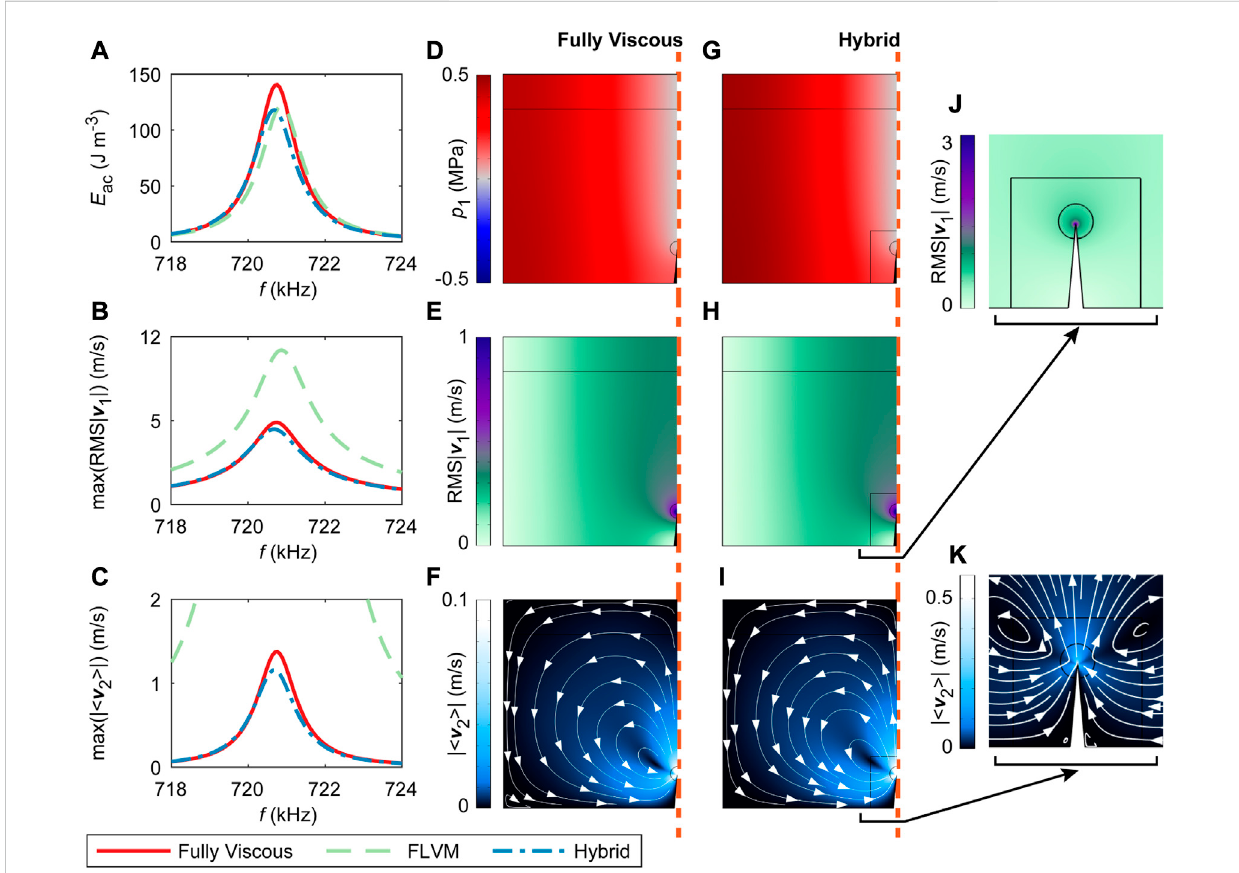
FIGURE 5 Different modeling approaches validated with a rectangular channel containing a sharp-edge structure. We compare the performance of the Fully Viscous model according to Muller et al. [15], the FLVM model from [22], and the Hybrid model outlined in Figure 2 that combines the two former approaches. The comparison is madefor the fi rst resonance modeinwater alongthechannelwidth a = 1 mm, with h =100 μ m, b =150 μ m, and α = 10 ° . (A) Average acoustic energy density E ac , (B) maximal root-mean-square acoustic velocity RMS| v 1 |, and (C) maximal Eulerian streaming velocity magnitude | 〈 v 2 〉 |. (D), (G) Half of the acoustic pressure fi elds that are otherwise antisymmetric. (E), (H) Half of the root-mean-square acoustic velocity magnitudes that are otherwise symmetric. (F), (I) Half of the Eulerian streaming velocity fi elds that are otherwise symmetric. (J), (K) Zoomed-in fi elds corresponding to (H) and (I) , respectively. (D) – (F) From theFully Viscous model; (G) – (K) from the Hybrid model. All the displayed fi eldscorrespond to f = 720 kHz. The fi elds from the FLVM model are omitted, since they are erroneous due to the inherent assumptionsof the model (as a note, the